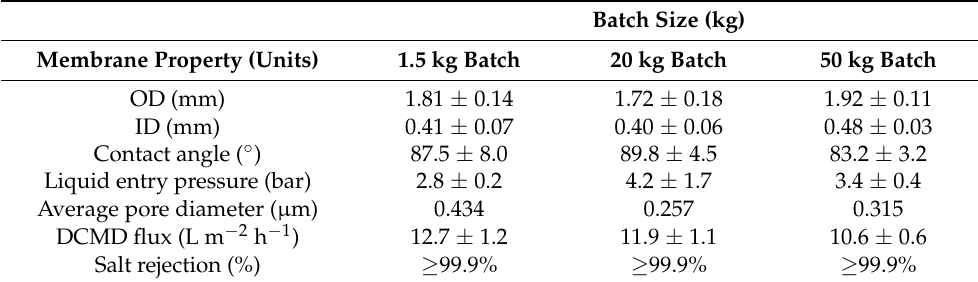
Table 4. DCMD and VMD performance of 0.5-inch and 2-inch modules consisting of PVDF TBHF membranes prepared from 50 kg batches. Tests were carried out in out-to-in mode using 35 g L − 1 Table 3. Characterization and DCMD performance of membranes prepared from different batch sizes. NaCl as the feed and DI water as the permeate-side liquid in DCMD. DCMD flux and salt rejection were determined using 0.5-inch modules under out-to-in mode and a feed solution of 35 g L − 1